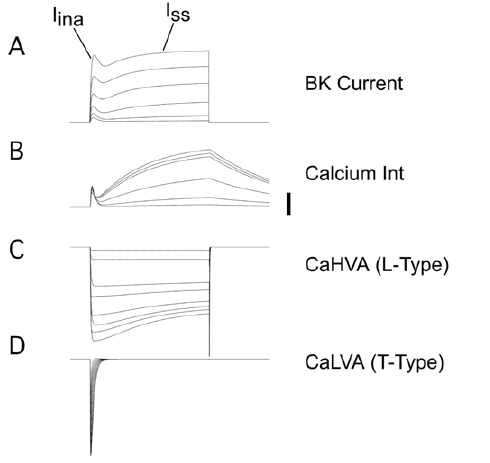
Figure 11. Model of Ca 2 z -channel kinetics underlying the BK currents. (A) The BK current was obtained assuming that there are two pools of BK channels as explained in the text. The equations for the activation of BK channels from eqs. (1,2). The equation for the Ca 2 z d ½ Ca z 2 (cid:2) concentration is Figure 12. Shell model for solution of Ca 2 z -diffusion problem. (A) The space is divided in spherical shells of thickness of 20 nm and the Ca 2 z channel is localized at the center of this configuration ( Ca 2 z Source). The distance of the BK channel to the Ca 2 z source is indicated by R. The equations to be solved on this geometry are the diffusion equation and the interaction with the mobile Ca 2 z buffer equations 5–7. The mobile buffers Bi are also subject to diffusion. We integrated these equations over the spheres taking N points at the middle of the shells where, r 0 ~ D r = 2, and r j ~ r j { 1 z D r ~ j D r z D r = 2( j § 0) . Integrating